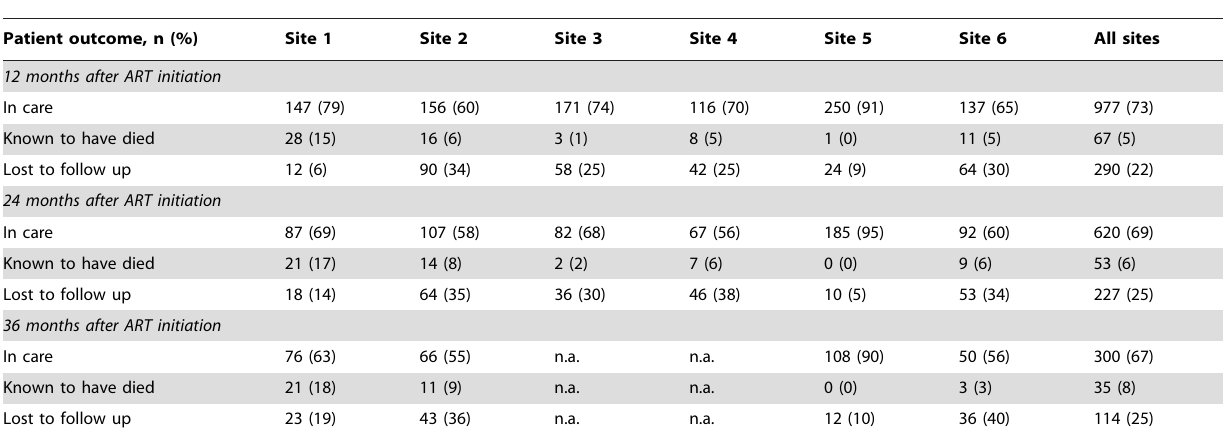
Table 2. Patient outcomes at six ART treatment sites in Zambia by site and time on treatment.